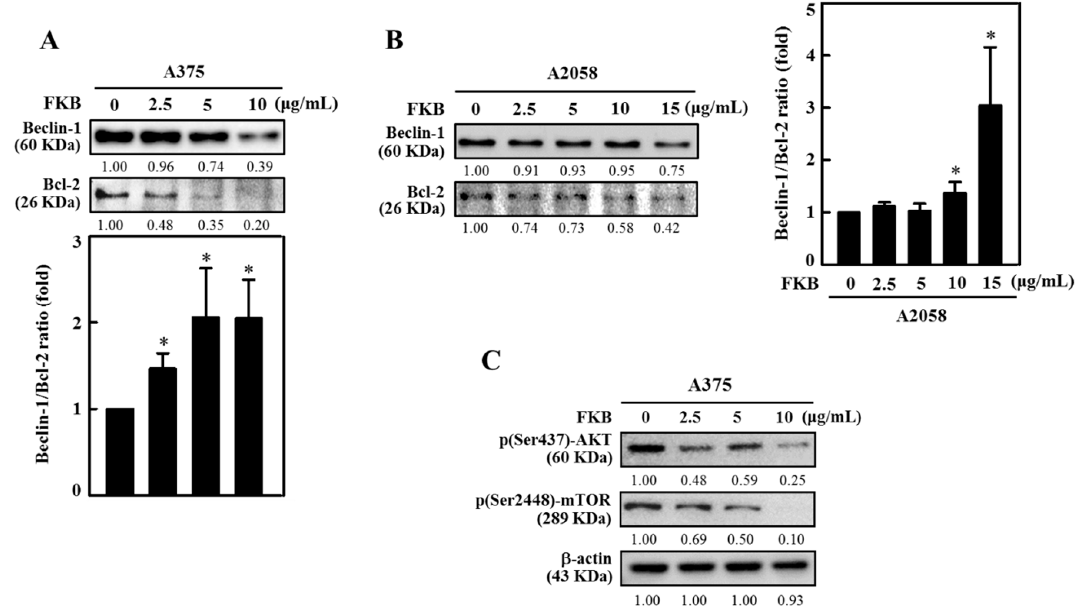
Figure 6. FKB dysregulated Beclin-1/Bcl-2 ratio and suppressed p-AKT/p-mTOR expressions in melanoma cells. Cells were treated with increasing concentrations of FKB (0–10 and 0–15 µg/mL) for 24 h. After the incubation period, cells were harvested and subjected to the Western blot method as described in the methods section. ( A , B ) FKB dose-dependently significantly upregulated the ratio between Beclin-1 and Bcl-2 in both A375 and A2058 cells. ( C ) FKB dose-dependently suppressed the phosphorylation of AKT and mTOR proteins. Both these effects shifted the cellular homeostasis towards autophagy. Each value was expressed as mean ± standard deviation (SD) of three experiments. Statistical significance was assigned as * p < 0.05 compared to untreated control.